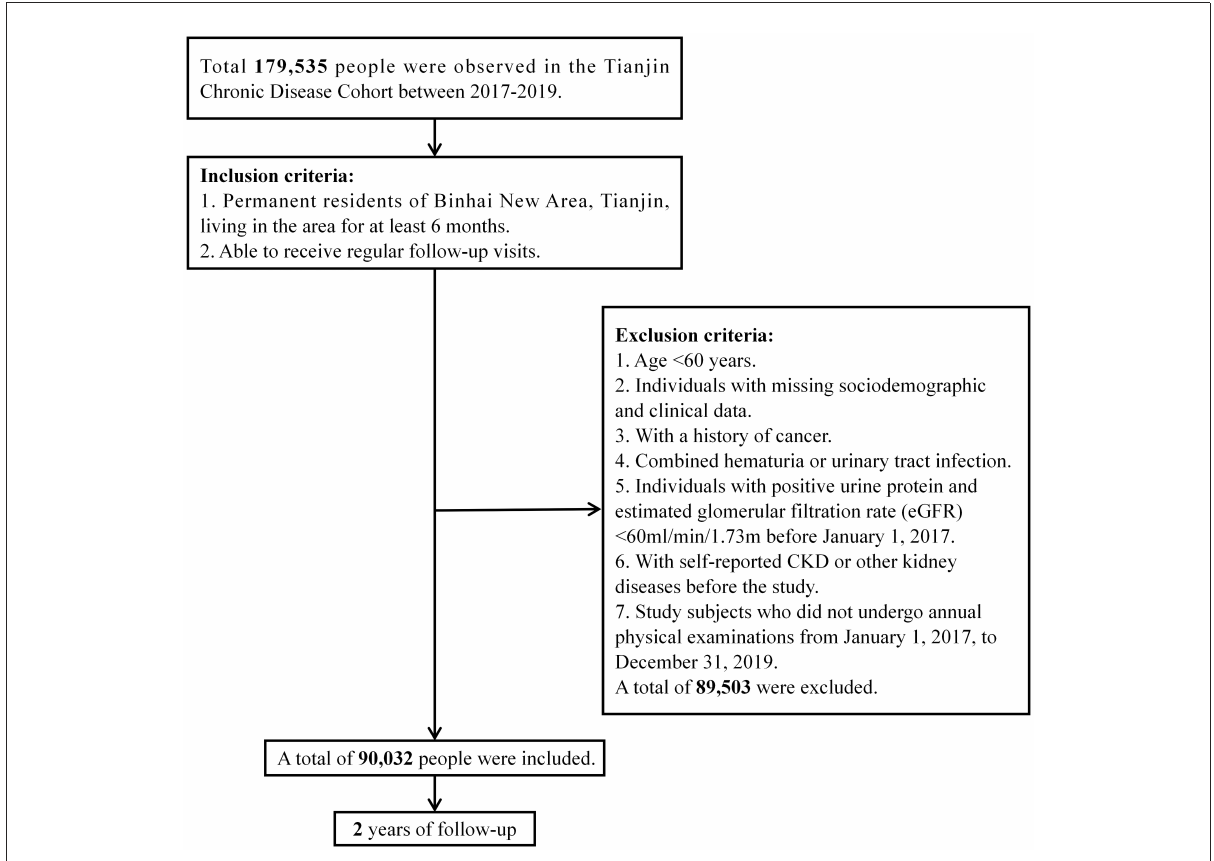
FIGURE1 Flow chart of the